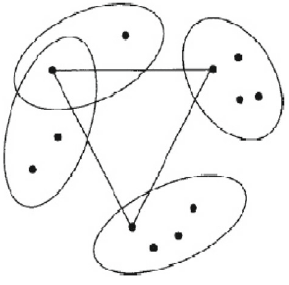
Fig. 1 Tpye-1 GTSP (only one node from each group)